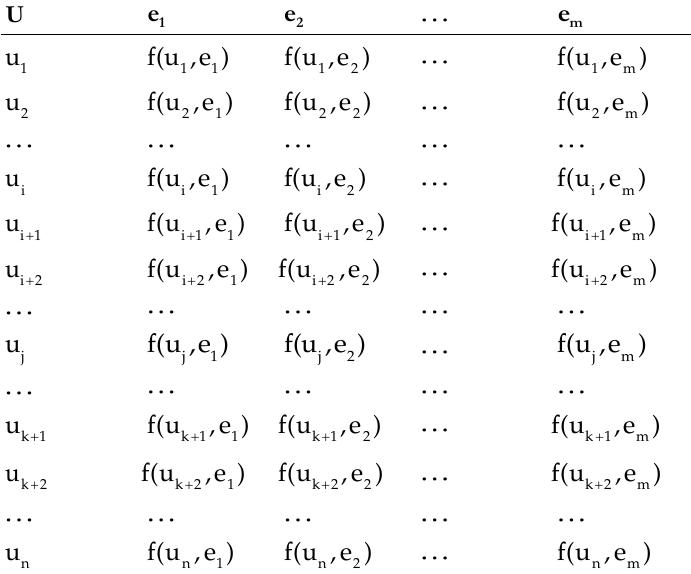
Table 1. Tabular representation of soft